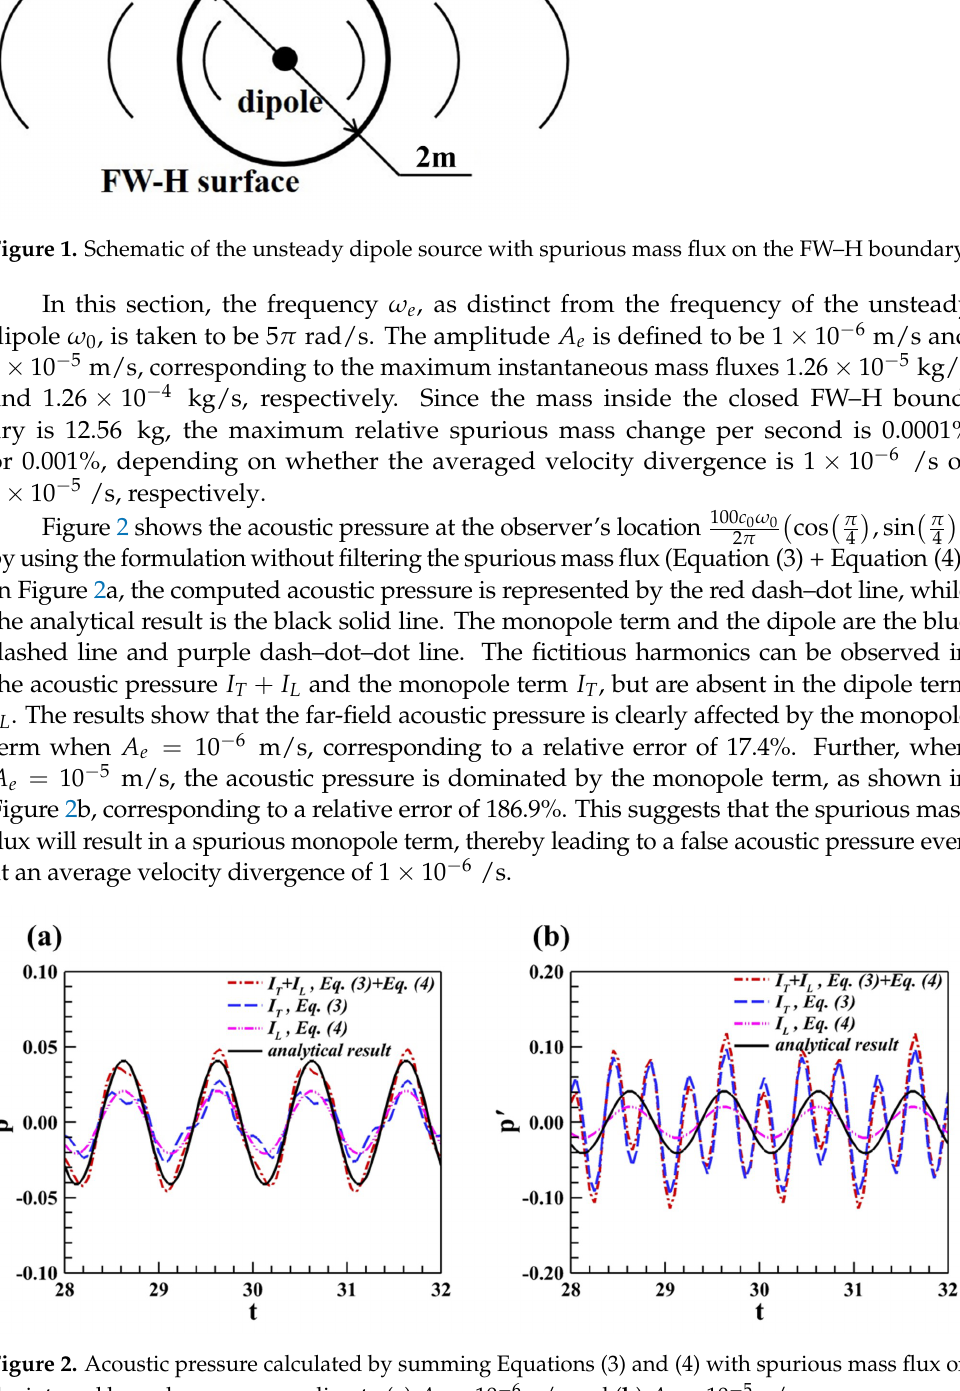
(cid:0) (cid:0) π (cid:1) (cid:0) π (cid:1)(cid:1) cos , sin . 2 π 4 4